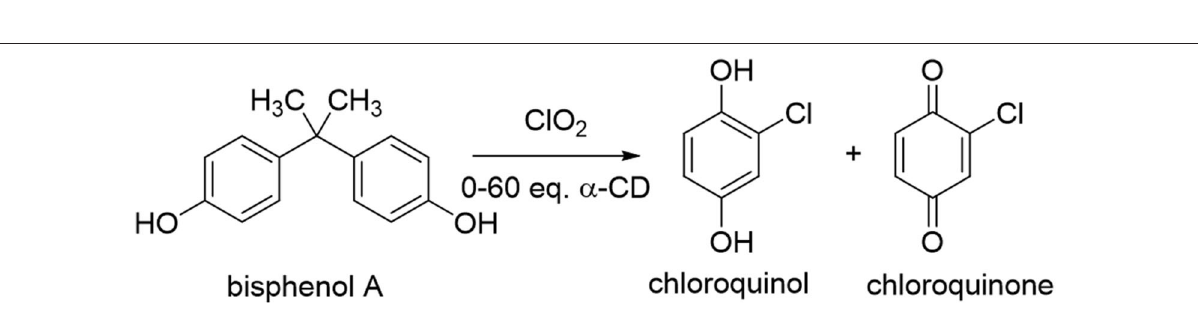
FIGURE 3 | Illustration of the degradation reaction of bisphenol A upon treatment with chlorine dioxide at 40 ◦ C.